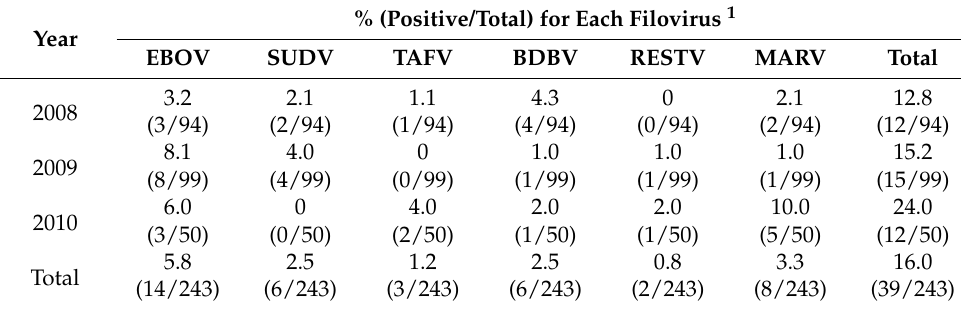
Table 1. Seropositive rates of NHPs for filoviruses.